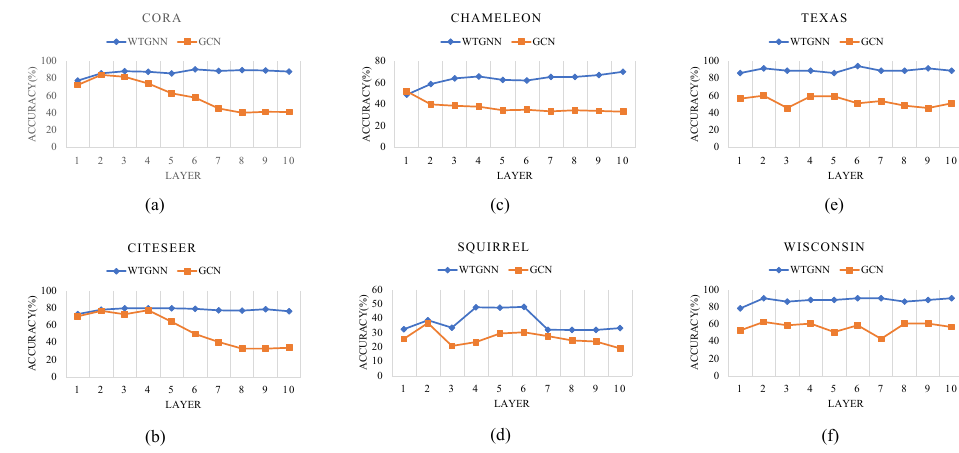
Figure 6. The performance of WTGNN under different layers tested on Cora, CiteSeer, Chameleon, Squirrel, Wisconsin, and